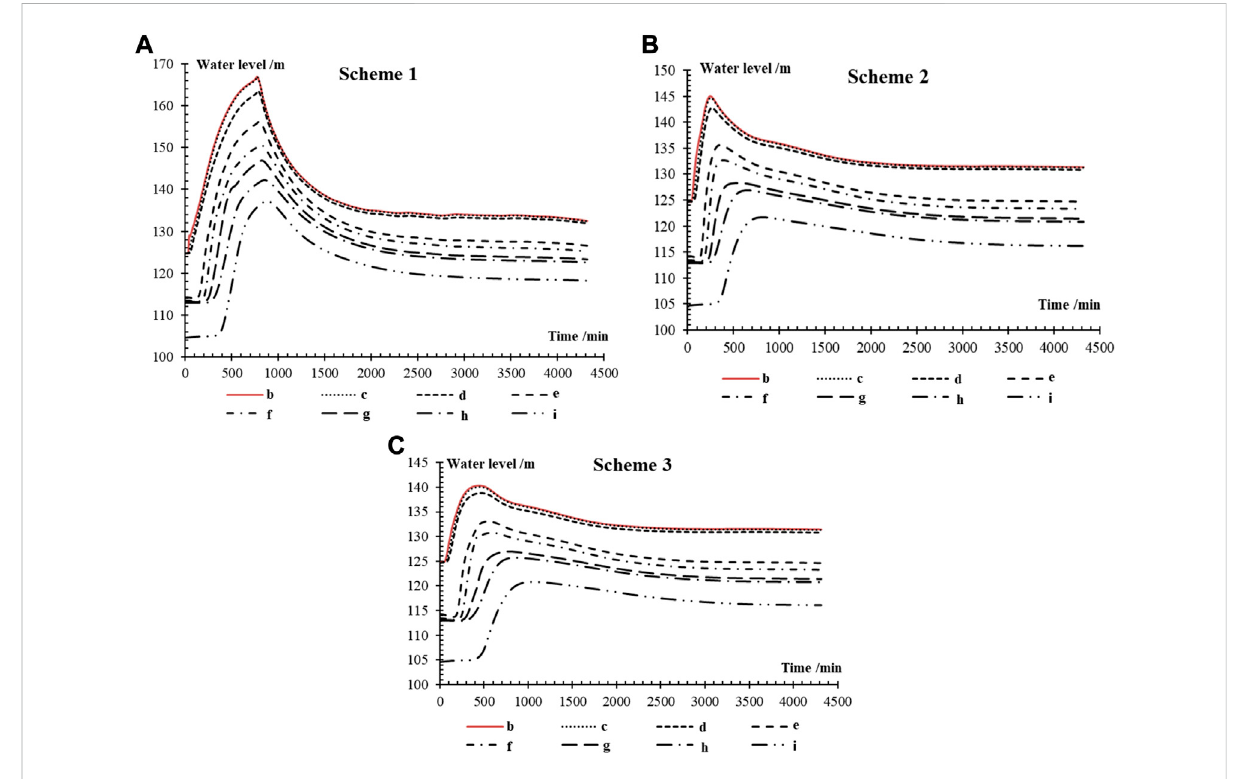
FIGURE 7 The stage hydrograph of all program characteristic sections.